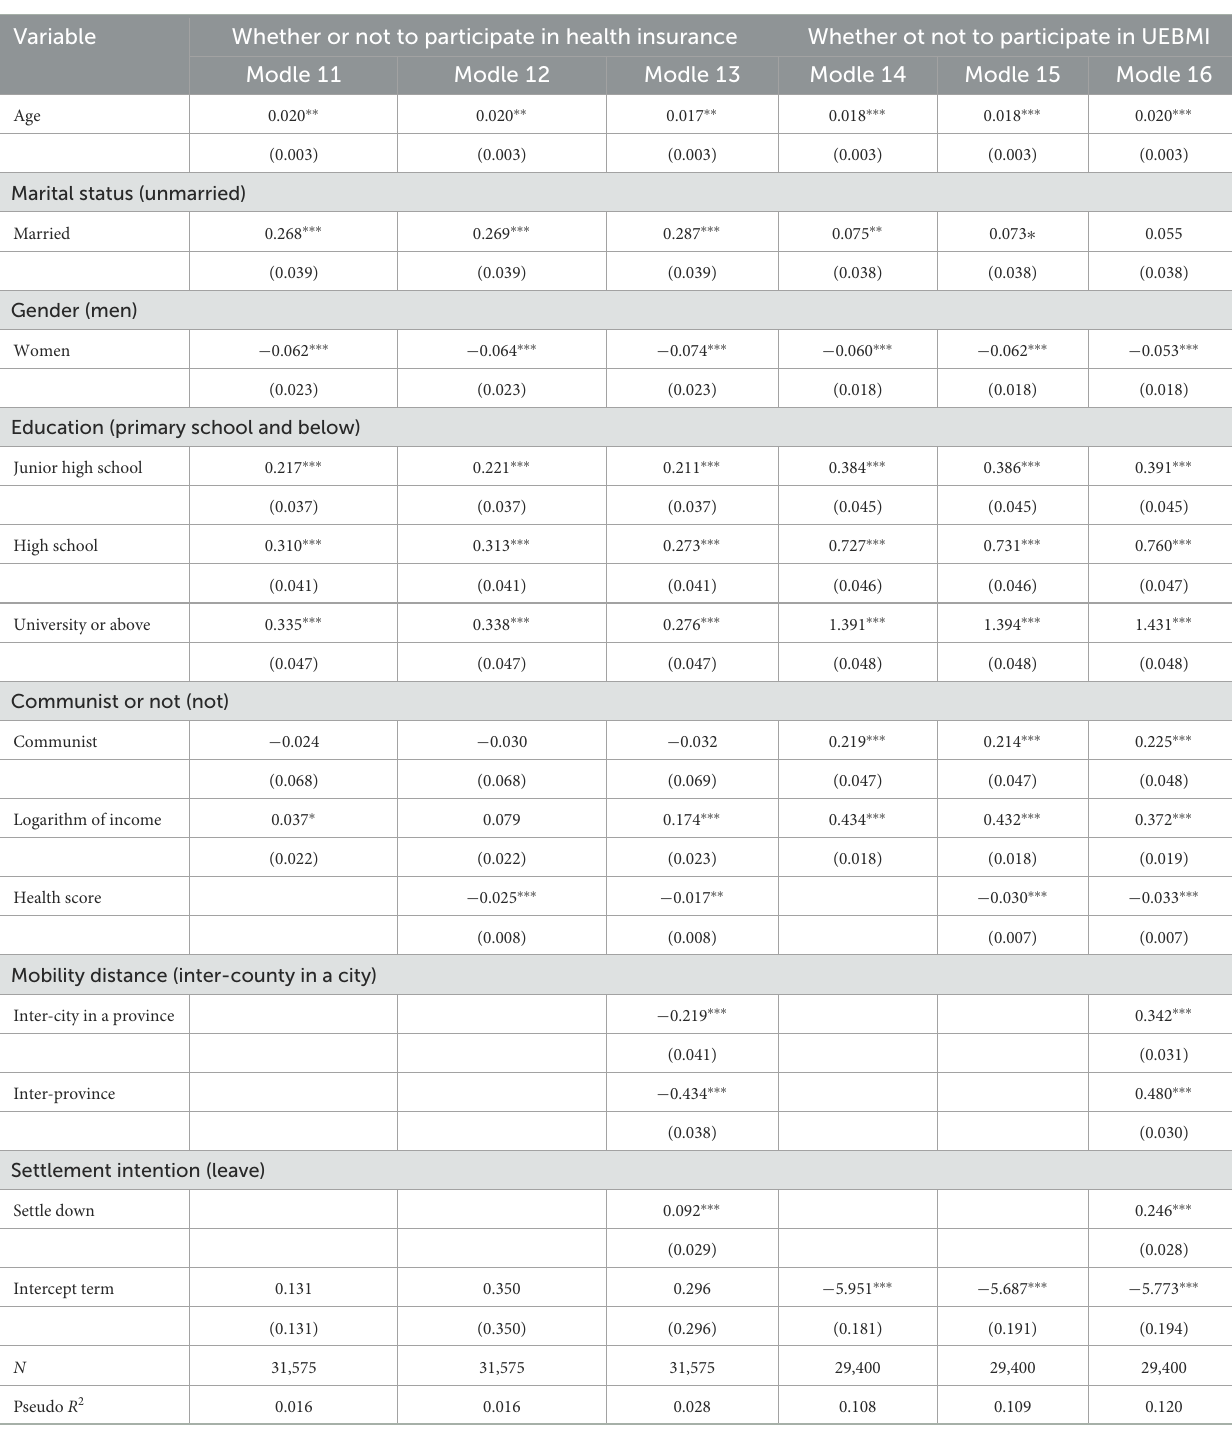
TABLE 6 Regression results after tailing of control variables (income).